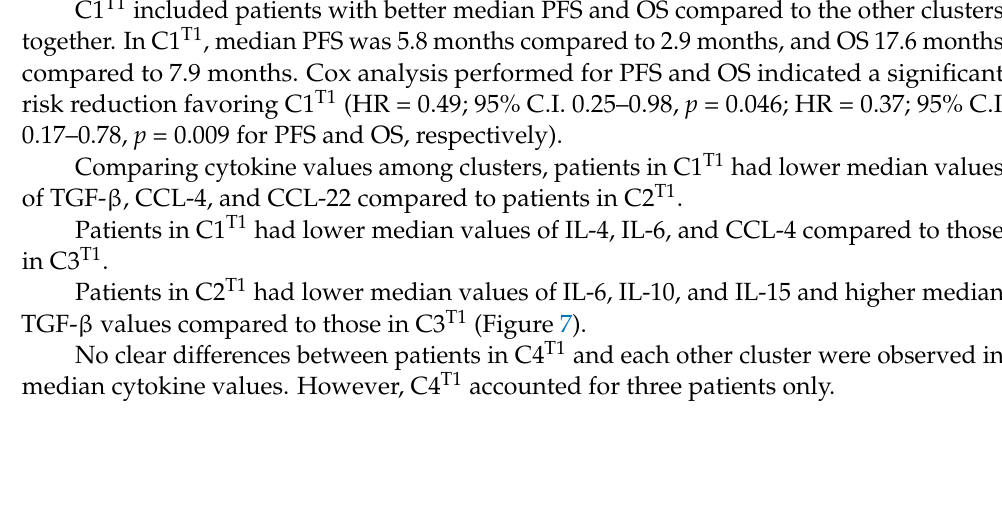
Figure 5. HCPC clustering with all cytokine values normalized at T1. On the x -axis is plotted first PC and on the y -axis second PC. Each patient is represented by a single dot number, labelled with a color of the cluster in which it belongs. Centroids are shown as bigger symbol and with no number.